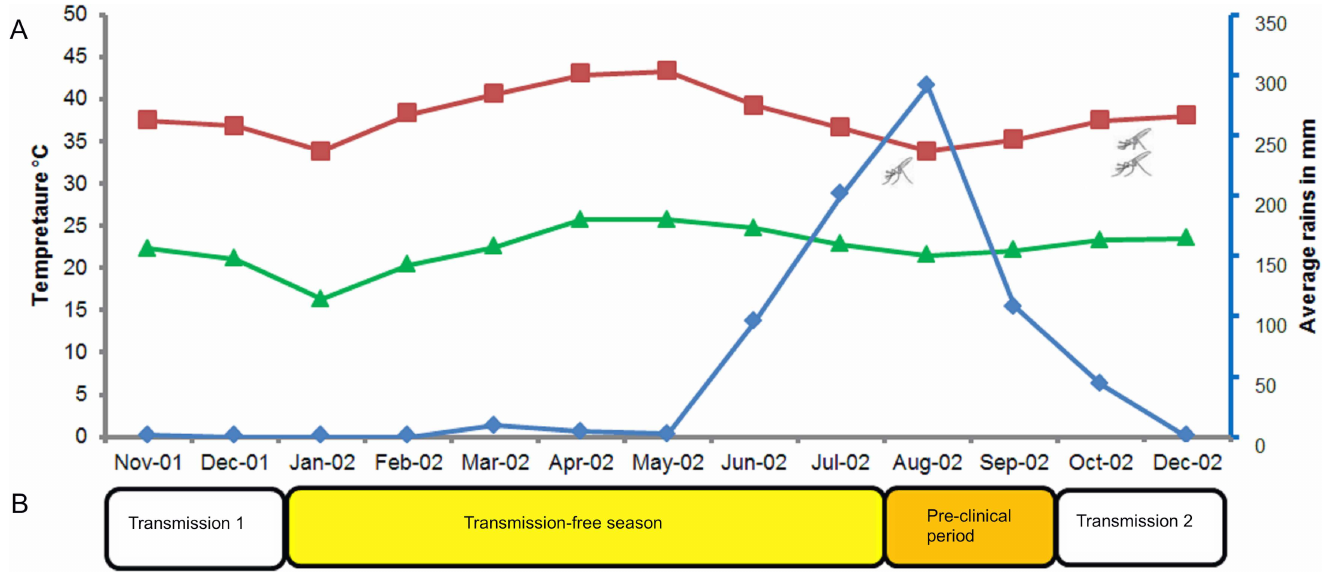
Fig 1. Seasonality of annual rains, mosquito abundance, and categorisation of seasons. (A) Monthlyaveragerainfallin mm (blue line), maximum (red line) and minimum (green line) temperature in the study area between November 2001 and December 2002 (Meteorological Authority, Sudan). Mosquitosymbols indicatethe expectedappearanceof mosquitoes(July 2002) and peak mosquitodensities(October 2002). (B) Distinct epidemiological phases of malaria transmission;transmissionseason 1 (Novemberto December 2001), transmission-free season (Januaryto July 2002), pre-clinical period (August and September 2002) and transmission season 2 (October and December 2002).